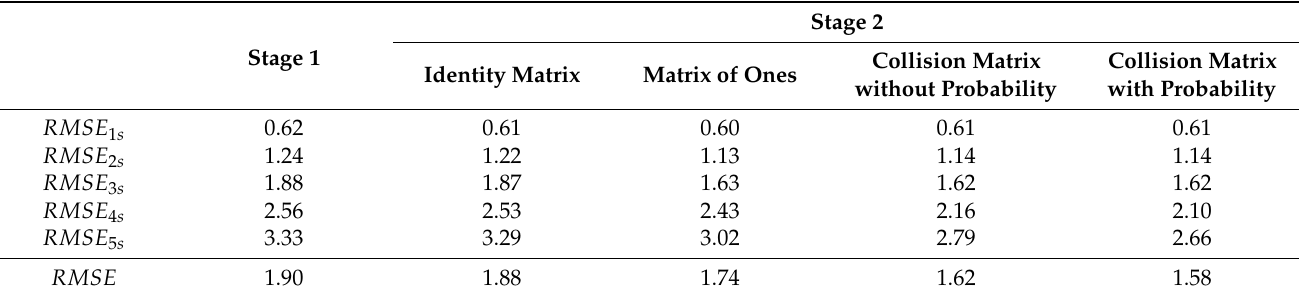
Table 1. Comparison of RMSE errors for ablation studies of the proposed method. Stage 1 Identity Matrix Matrix of Ones